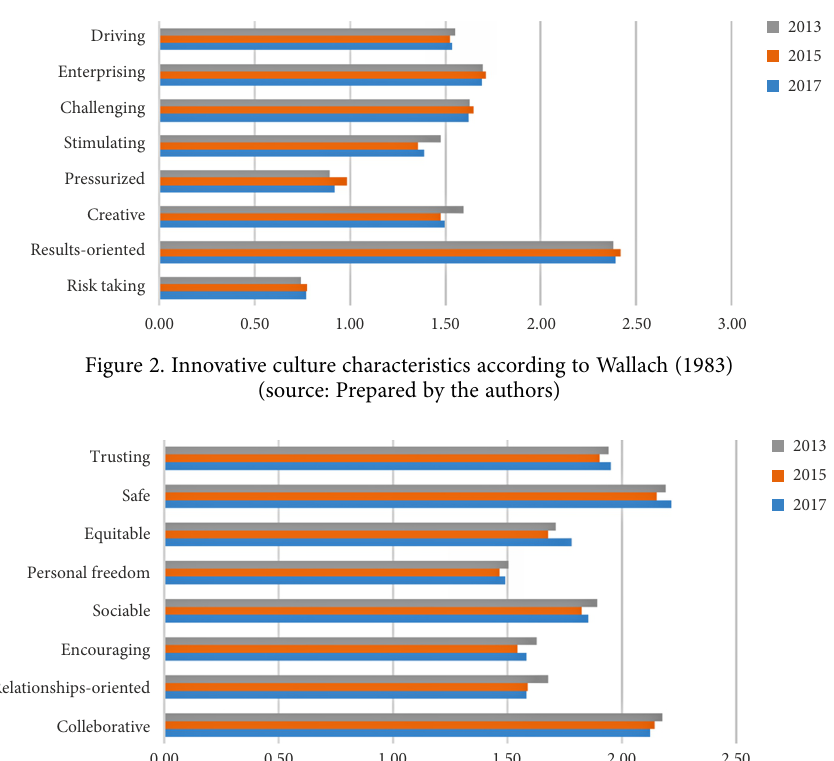
Figure 1. Bureaucratic culture characteristics according to Wallach (1983) (source: Prepared by the authors)